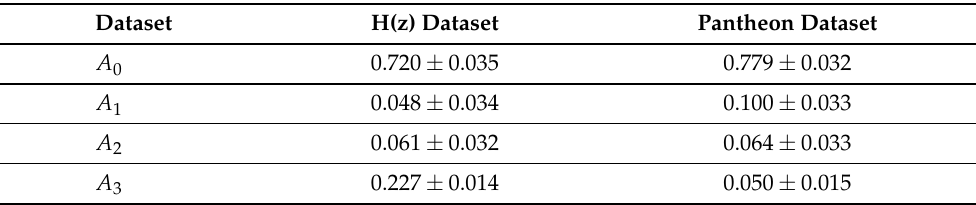
Table 1. The marginalized constraining results on four model parameters are shown by using the Hubble and Pantheon SNe Ia